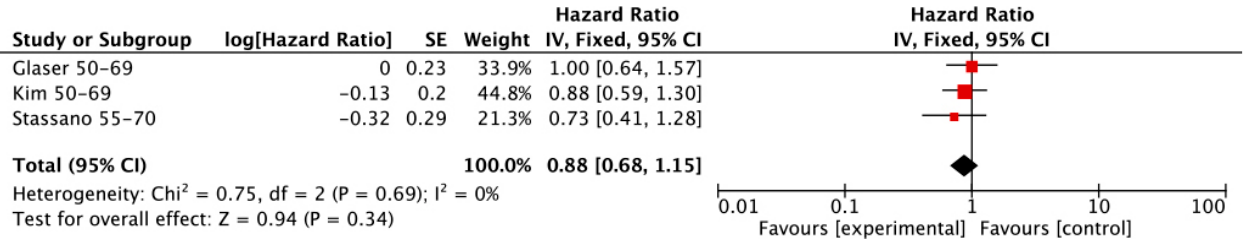
Figure 4. Meta ‐ analysis for freedom from cardiac death: bioprosthetic vs. mechanical. Figure 4. Meta-analysis for freedom from cardiac death: bioprosthetic vs.